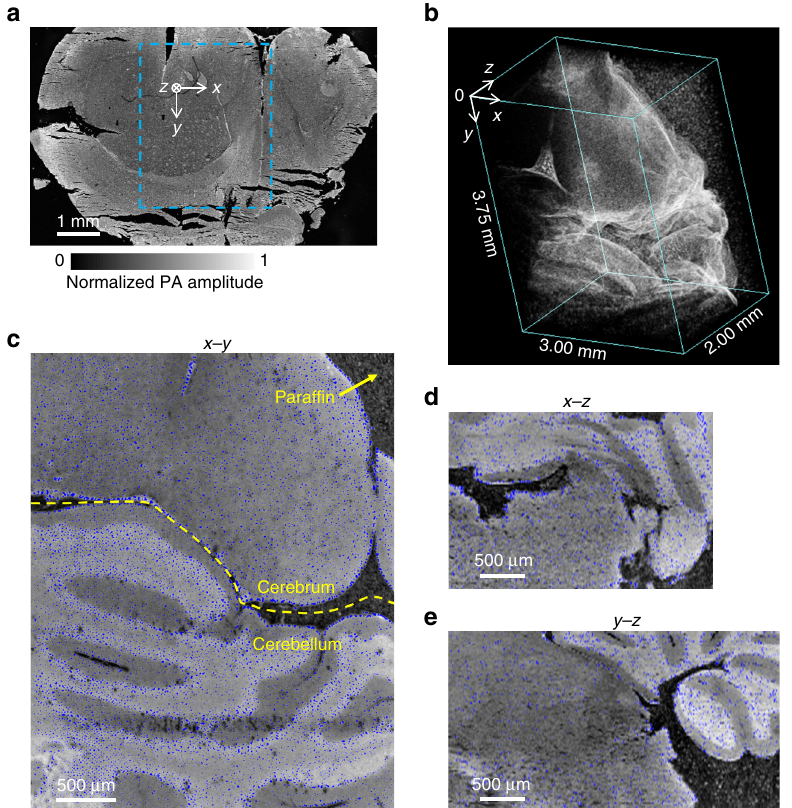
Fig. 2 3D label-free mPAM image of an unstained mouse brain embedded in a paraf fi n block. a A section of the entire mouse brain image (coronal view). b A 3D view of the imaged brain block corresponding to the marked region in a . c x – y image at z = 0.16 mm (coronal view), with the cell nuclei marked in blue. The yellow dashed line outlines the boundary between the cerebrum and the cerebellum. d x – z image at y = 2.31 mm (transverse view). e y – z image at x